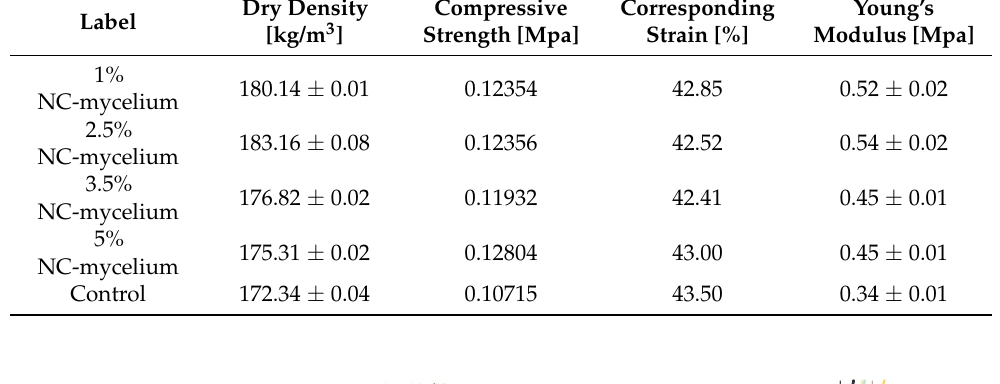
Table 4. Overview of material properties in compression of mycelium composites grown with 1 to 5% nanoclay. The standard deviation is performed with three specimens.